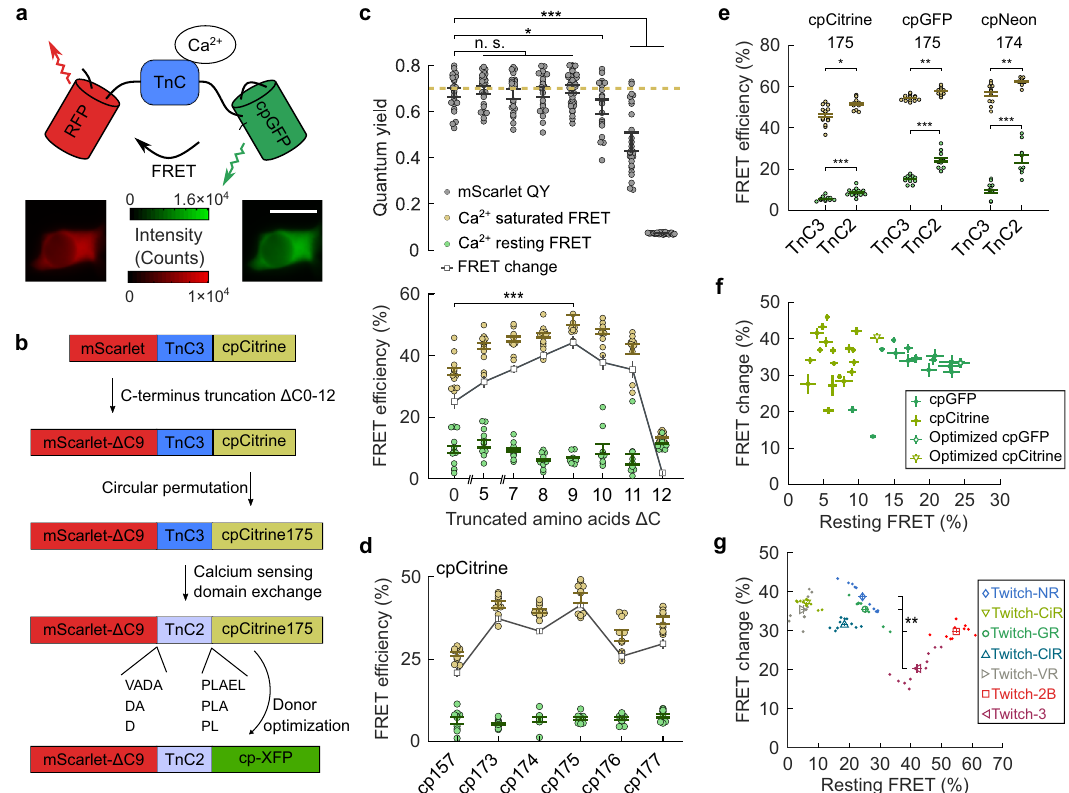
Fig. 1 Rational design on the fl uorescent proteins and linkers created sensors with high Ca 2 + sensitivity. a Schematic representation of the sensor construct linking the RFP (mScarlet), calcium sensing domain (TnC), and circularly permuted GFP-analog in series. The two inset images represent the fl uorescence intensity in the two imaged channels from one example cell. The illumination intensity was 5 mW/mm 2 . The scale bar is 20 µ m. b A schematic illustration shows various sensor designs that maximized on the Ca 2 + sensitivity after improvements through amino acid truncation, circularly permutation, sensing domain optimization, linker optimization, and donor optimization. The XFP referred to a set of fl uorescent proteins including mNeonGreen, mCitrine, EGFP, mClover3, or mVenus. c The FRET ef fi ciency of the sensor and the quantum yield of the acceptor remained high for truncations of mScarlet shorter than 9 amino acids. Larger truncations not only extinguished the red fl uorescence, but also signi fi cantly reduced the FRET ef fi ciency between the green and red fl uorescent proteins. The horizontal dash represents the reported quantum yield of native mScarlet. ( d ) Circular permutation of the mCitrine donor at speci fi c locations optimized the FRET ef fi ciency change between the sensors ’ Ca 2 + -resting state and Ca 2 + -saturated state. e Sensors using the TnC2 calcium sensing domain had signi fi cantly higher Ca 2 + -saturated FRET ef fi ciency ( yellow ) and the Ca 2 + -resting state FRET ef fi ciency ( green ) than those of sensors using the TnC3 calcium sensing domain. f The relationship between the resting-Ca 2 + FRET ef fi ciency of sensors and the change in FRET ef fi ciency for various linkers between sensing domains and fl uorescent proteins. The optimal linker for each donor ( open triangular and circular symbols ) had both high resting FRET ef fi ciency and high FRET ef fi ciency change. g The relationship between the various FP pairs ’ resting FRET ef fi ciency and change in FRET ef fi ciency between Ca 2 + -resting and Ca 2 + -saturated states. Dots represent FRET metrics measured from individual cells, while the symbols represent the mean FRET metrics of each variant. All error bars are s.e.m., n ≥ 10 cells for each sensor. All statistical tests were the